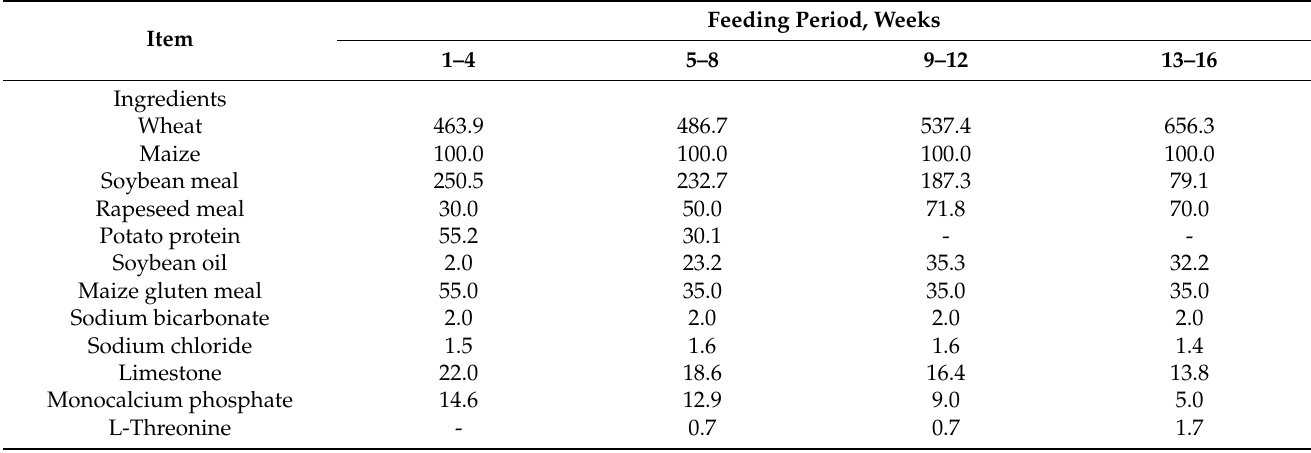
Table 1. Ingredient composition and nutrient content of basal diets (g/kg, as-fed basis) fed to